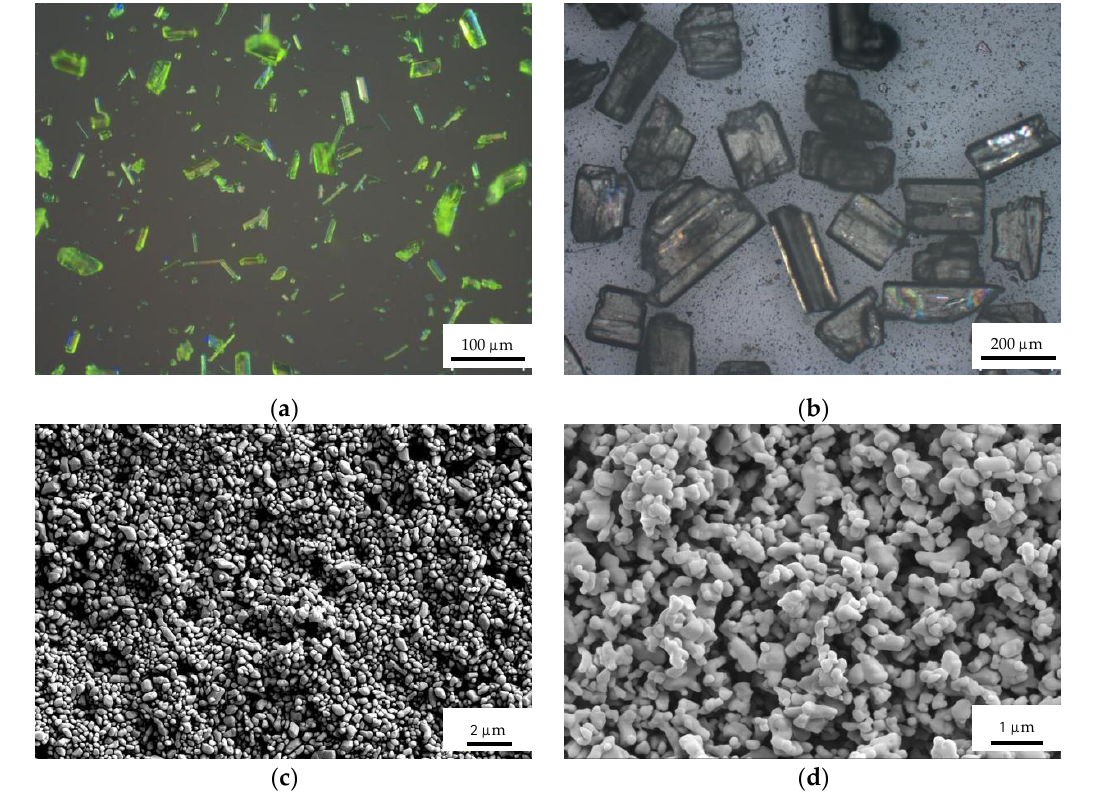
Figure 1. Optical microscope and SEM images of samples: ( a ) Raw LLM-105; ( b ) Raw HNS; ( c ) Ultra- fine LLM-105; ( d ) Ultra-fine HNS.